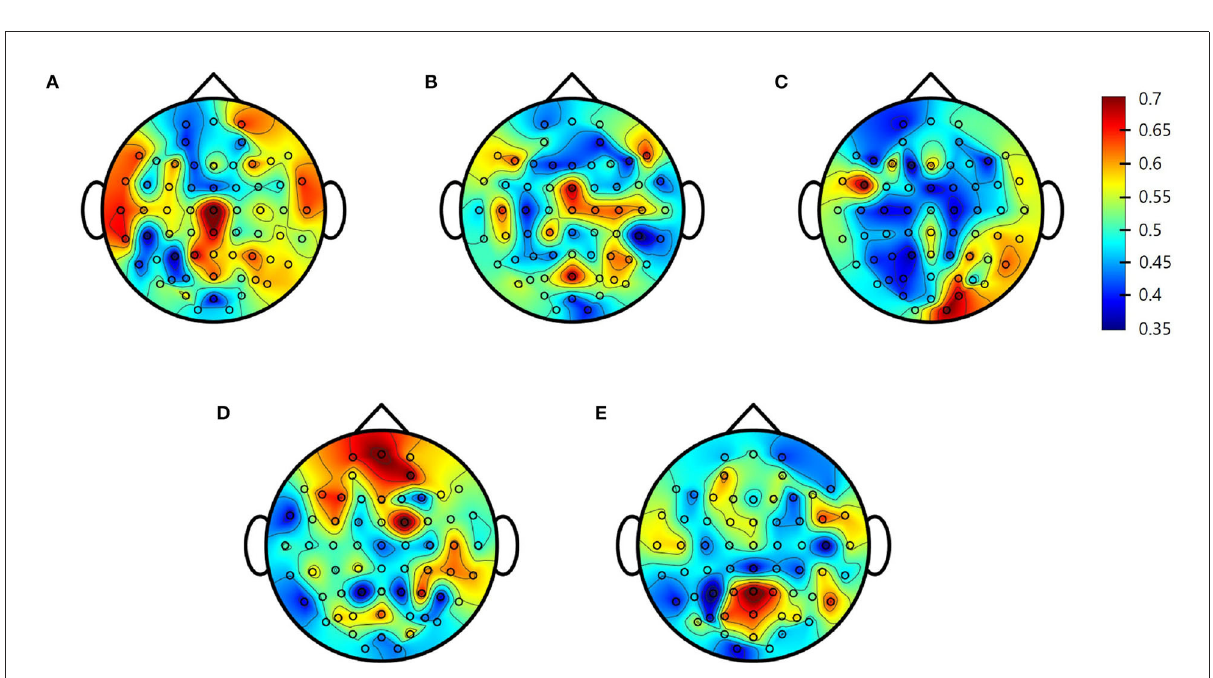
F2 channels provided a much better performance at 0.93. Table